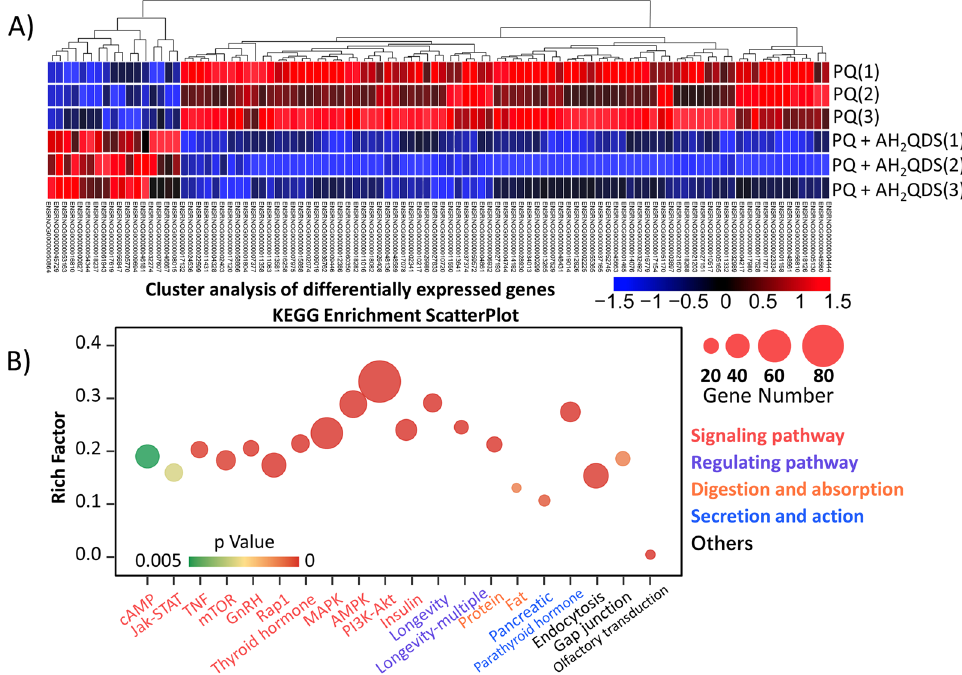
Figure 9. Differentially expressed genes by using NextGen sequencing method. ( A ) Heat map of differentially expressed gene expression profiles of the PQ group and the PQ + AH 2 QDS group. Gene enrichment analysis was performed based on differentially expressed genes, and the blue to red color indicates the expression level from low to high. ( B ) Regulatory biological pathways under AH 2 QDS treatment were analyzed using the KEGG database. Rich Factor indicates the proportion of differential genes annotated to this KEGG Pathway as a percentage of genome-wide genes. The horizontal coordinate indicates the description bar of the KEGG Pathway. GeneNumber, the number of genes annotated to this KEGG Pathway among the differential genes used for enrichment. The size of the dot indicates the number of genes on the enrichment, and the colour indicates the Qvalue, the lower, the more